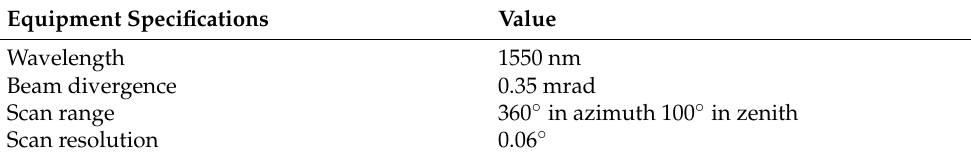
Table 4. Terrestrial laser scanning specifications